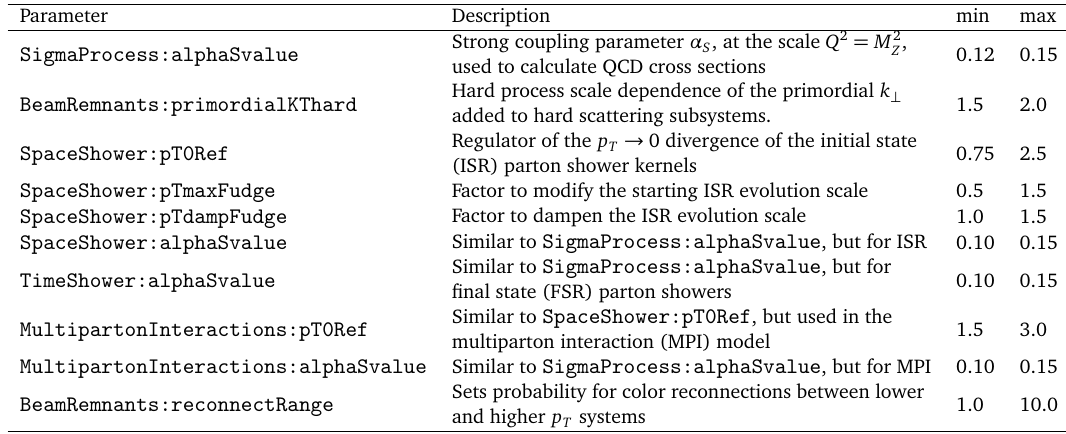
Table 15: P YTHIA physics parameters used in the A14 tune, their definitions, and tuning ranges (min, max). More details of the parameters can be found in the